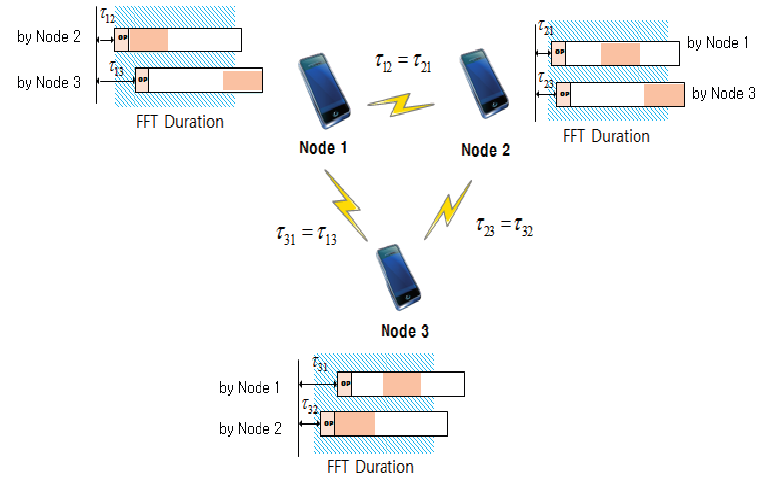
Figure 1. Example of an OFDMA-based WMN ( 3 N =